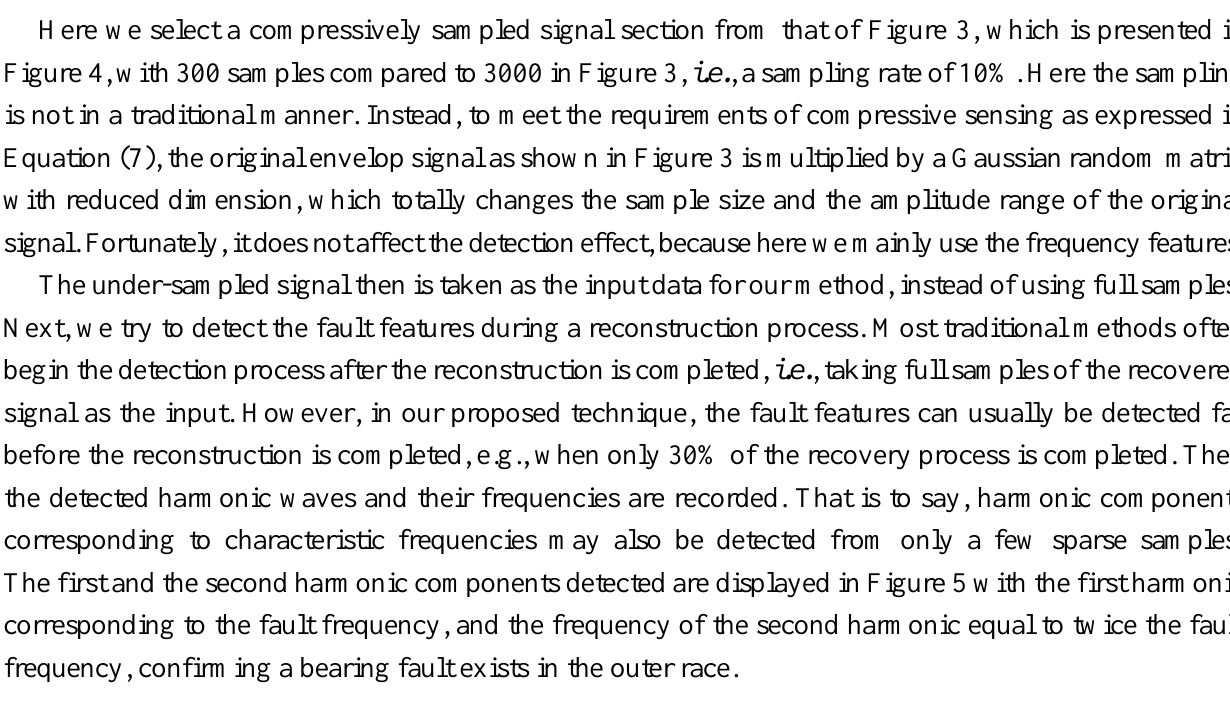
Figure 3. Envelope of the signal as shown in Figure